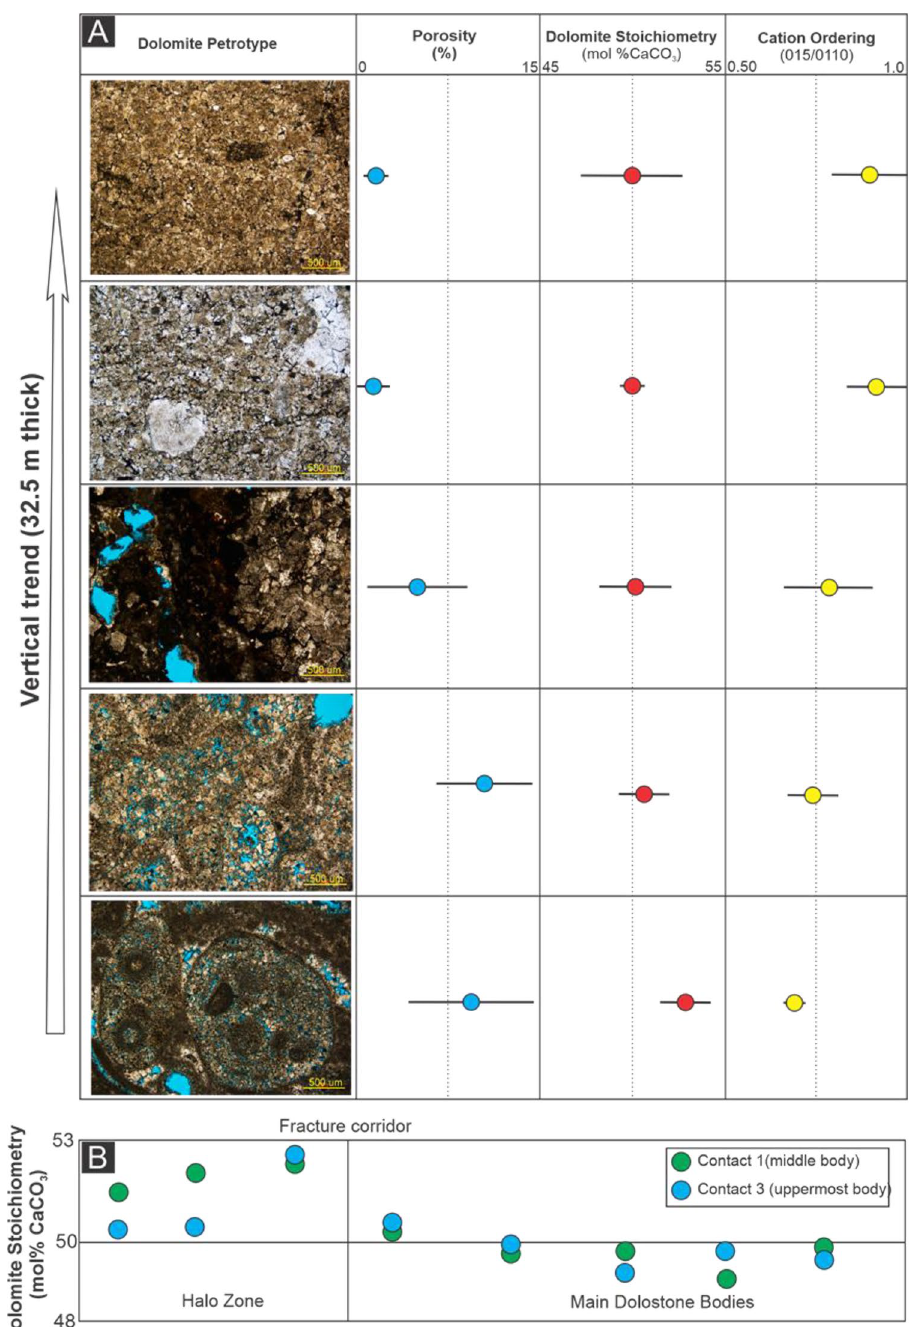
Figure 3. ( A ) Thin section images showing apparent changes in dolomite fabrics from FP (lower interval) to FD (upper interval). Overall, porosity decreases and dolomite stoichiometry-ordering increase upward. ( B ) A consistent pattern of less stoichiometric dolomite towards the dolomitization fronts and